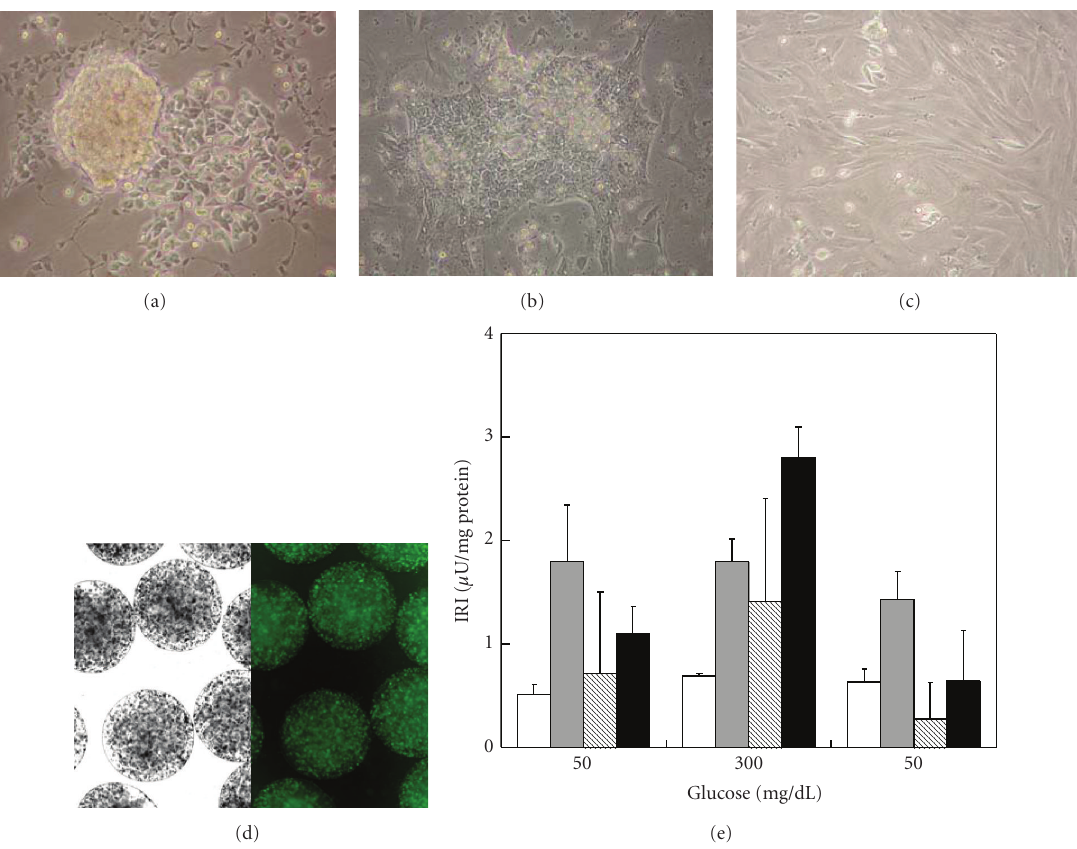
Figure 1: (a)–(c) Photomicrographs of NPI after culture for 1 (a), 6 (b), and 10 (c) days on T25 tissue flasks for adherent cell growth. (d) Light field (left) and fluorescence (right) photomicrographs of Ba-AG microcapsules containing SC. Fluorescence micrographs were obtained after staining with EB+FDA to assess SC viability. (e) Insulin secretory patterns of control NPI cell monolayers alone after 14 days (open bars) or NPI cell monolayers, cocultivated with microencapsulated SC for 7 (gray bars), 14 (hatched bars), and 21 days (filled bars) of culture. During static incubation, the cells were treated with the indicated concentrations of glucose. Data represent the average of 3 independent experiments; each insulin determination was performed in triplicate ±